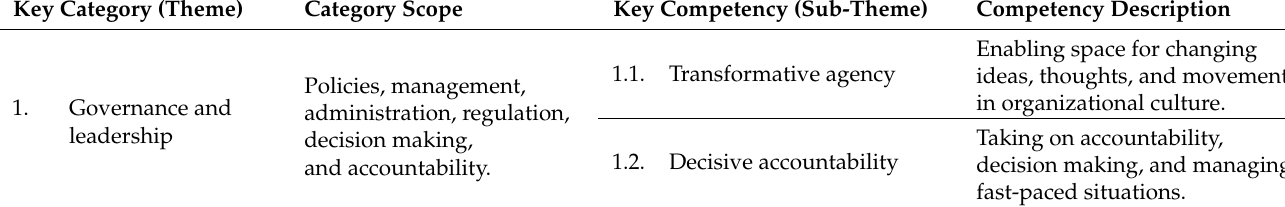
Table 1. Transformational leadership categories (themes) and competencies